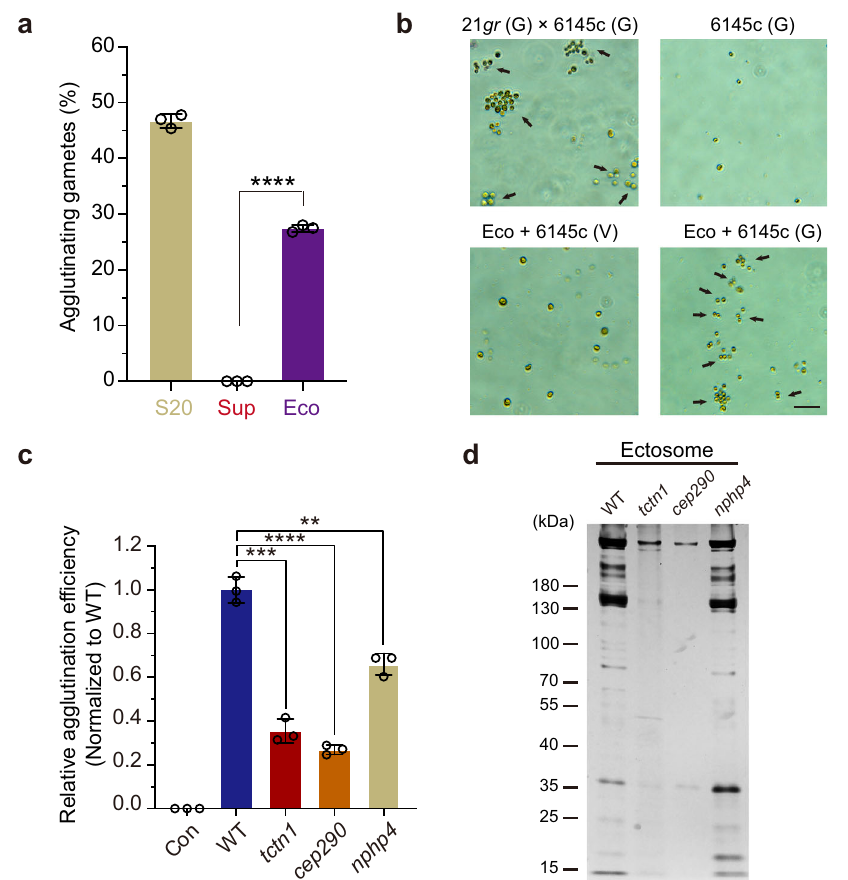
Fig. 7 The activity and protein composition of ciliary ectosomes shedding from gametes of different TZ mutants are different. a Bar – scatter graph depicting the agglutinating gametes number (%) from 6145c (mt-) mixed with the supernatant (S20), the fi nal supernatant (Sup), and ectosome pellet (Eco) from gamete mating culture (21 gr × 6145c). b PH images showing the agglutination of gametic 6145c (mt-) induced by mixing with the ectosomes (Eco). Gametic 6145c alone, vegetative 6145c with Eco, and 21 gr × 6145c were showed as the negative and positive controls, respectively. The black arrows indicate the agglutination of gametic cells. G gametic cells, V vegetative cells. Scale bar, 20 μ m. c Bar – scatter graph displaying the agglutination ef fi ciency (normalized to WT) of gametic 6145c (mt-) mixed with the ectosome pellet (Eco) from gamete mating cultures (21 gr × 6145c, tctn1 × 6145c, cep290 × 6145c, nphp4 × 6145c). The group of vegetative 6145c with Eco was as the negative control (Con). d Silver-stained SDS – PAGE gel showing protein variations in ectosomes isolated from the plus mating type gamete (21 gr , tctn1 , cep290 , nphp4 ) with minus mating type gamete (6145c). The indicated ciliary ectosomes puri fi ed from the same amount of cells were loaded with equal number of mating gametes, separated on 4 – 20% SDS – PAGE and then visualized by silver staining. The positions of standard proteins and their molecular masses in kDa are indicated. Data are presented as the mean ± SD ( n = 3, independent experiments) in this fi gure. Statistical signi fi cance was determined with an unpaired t test in this fi gure. ** P < 0.01; *** P < 0.001; **** P < 0.0001 by two tailed. Source data are provided as a Source Data fi